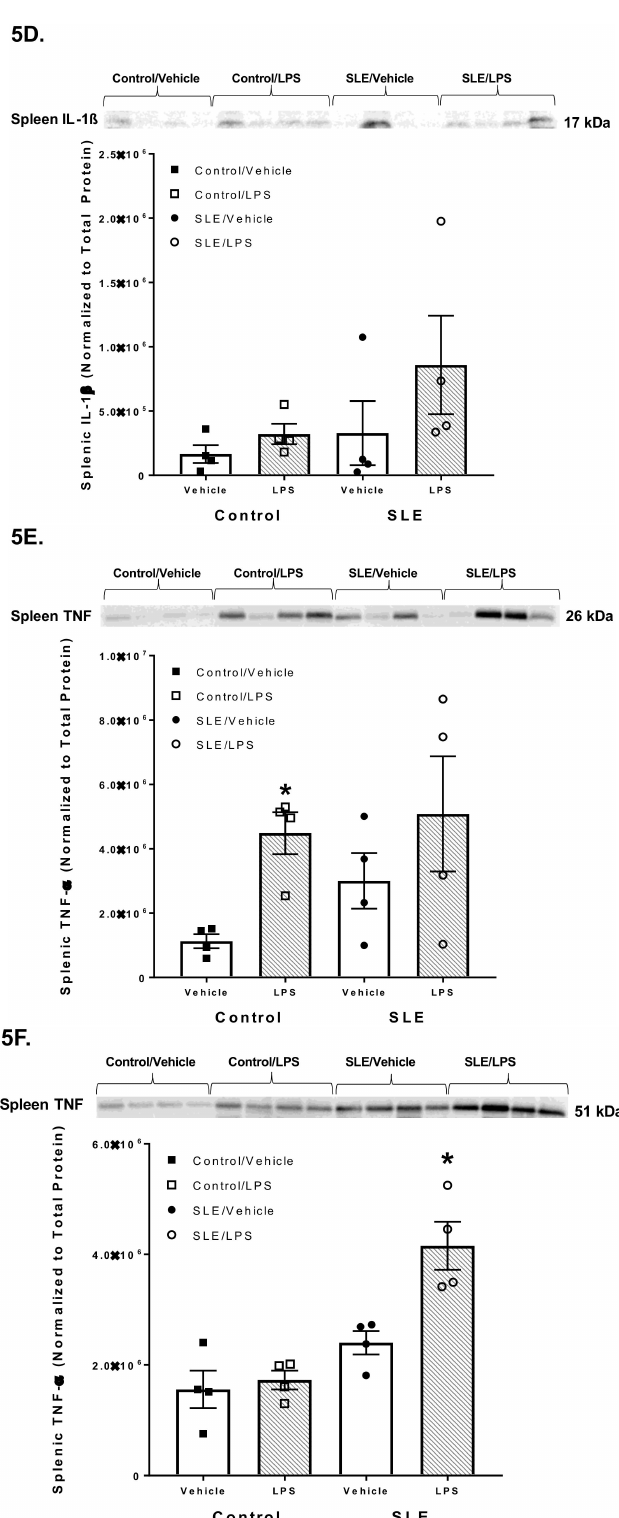
Figure 5. Pro-inflammatory cytokine expression was measured in brains and spleens of lipopolysaccharide (LPS)-challenged and vehicle-treated systemic lupus erythematosus (SLE) and control ( NZW ) mice. ( A ) Brain IL-1 β was elevated in SLE mice compared to controls. LPS-challenged controls had elevated brain IL-1 β compared to their vehicle-treated